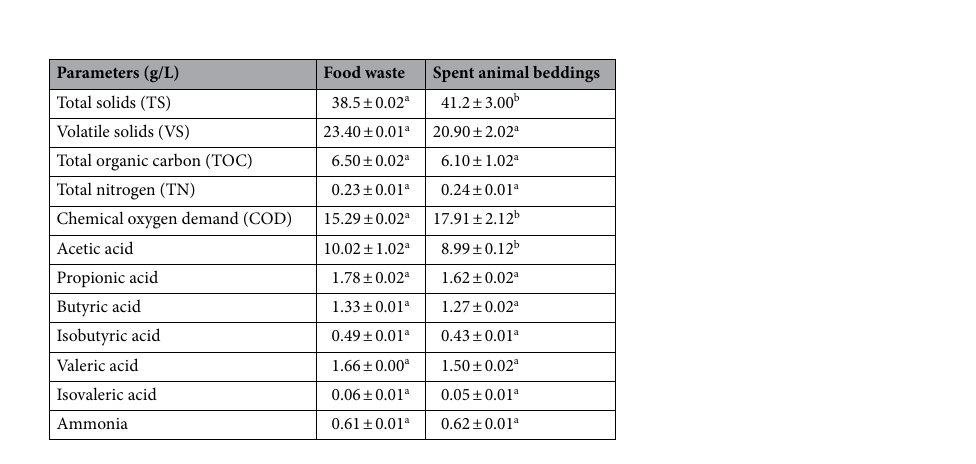
Table 1. Characteristics of fermentation liquid from food waste and spent animal beddings. Values shown in table are means of triplicate analyses with respective standard errors; superscripts with same letters are statistically the same by the Tukey’s test at